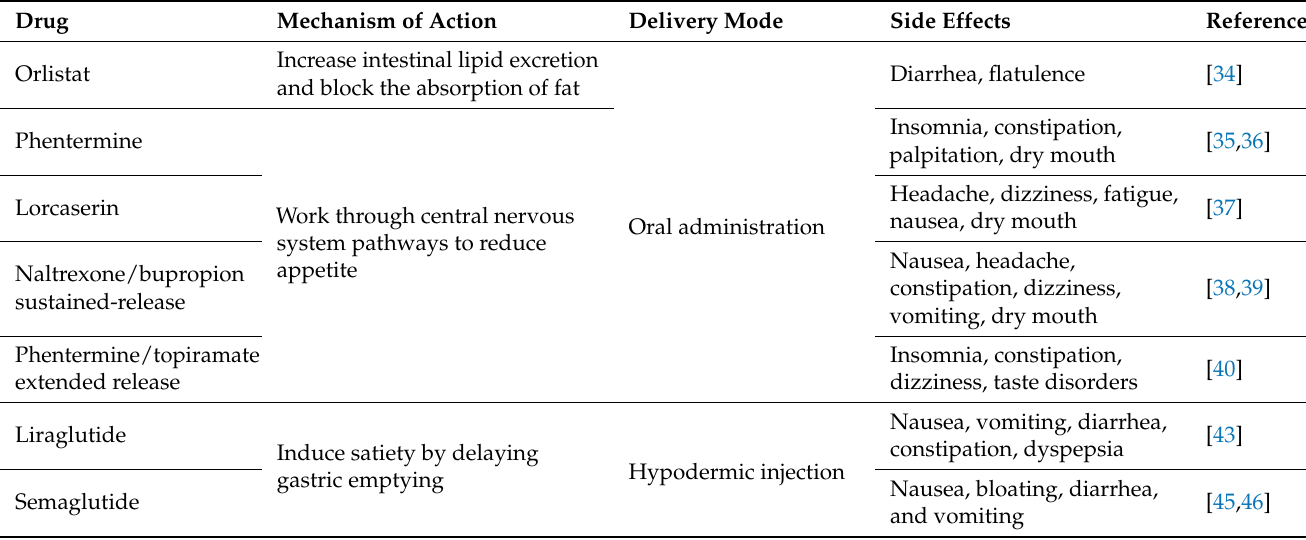
Table 1. Anti-obesity drugs approved by US